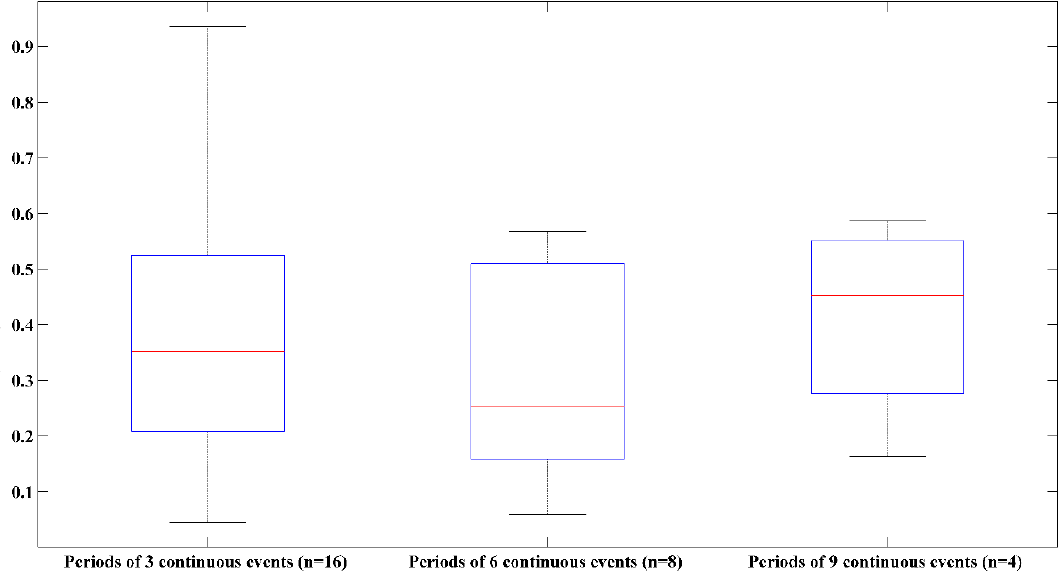
Figure 8. Boxplots of Nash–Sutcliffe coefficients obtained when calibrating over periods of three, six and nine continuous events. The central mark of each box is the median of the Nash coefficients, the edges represent the 25th and 75th percentiles, and the whiskers.